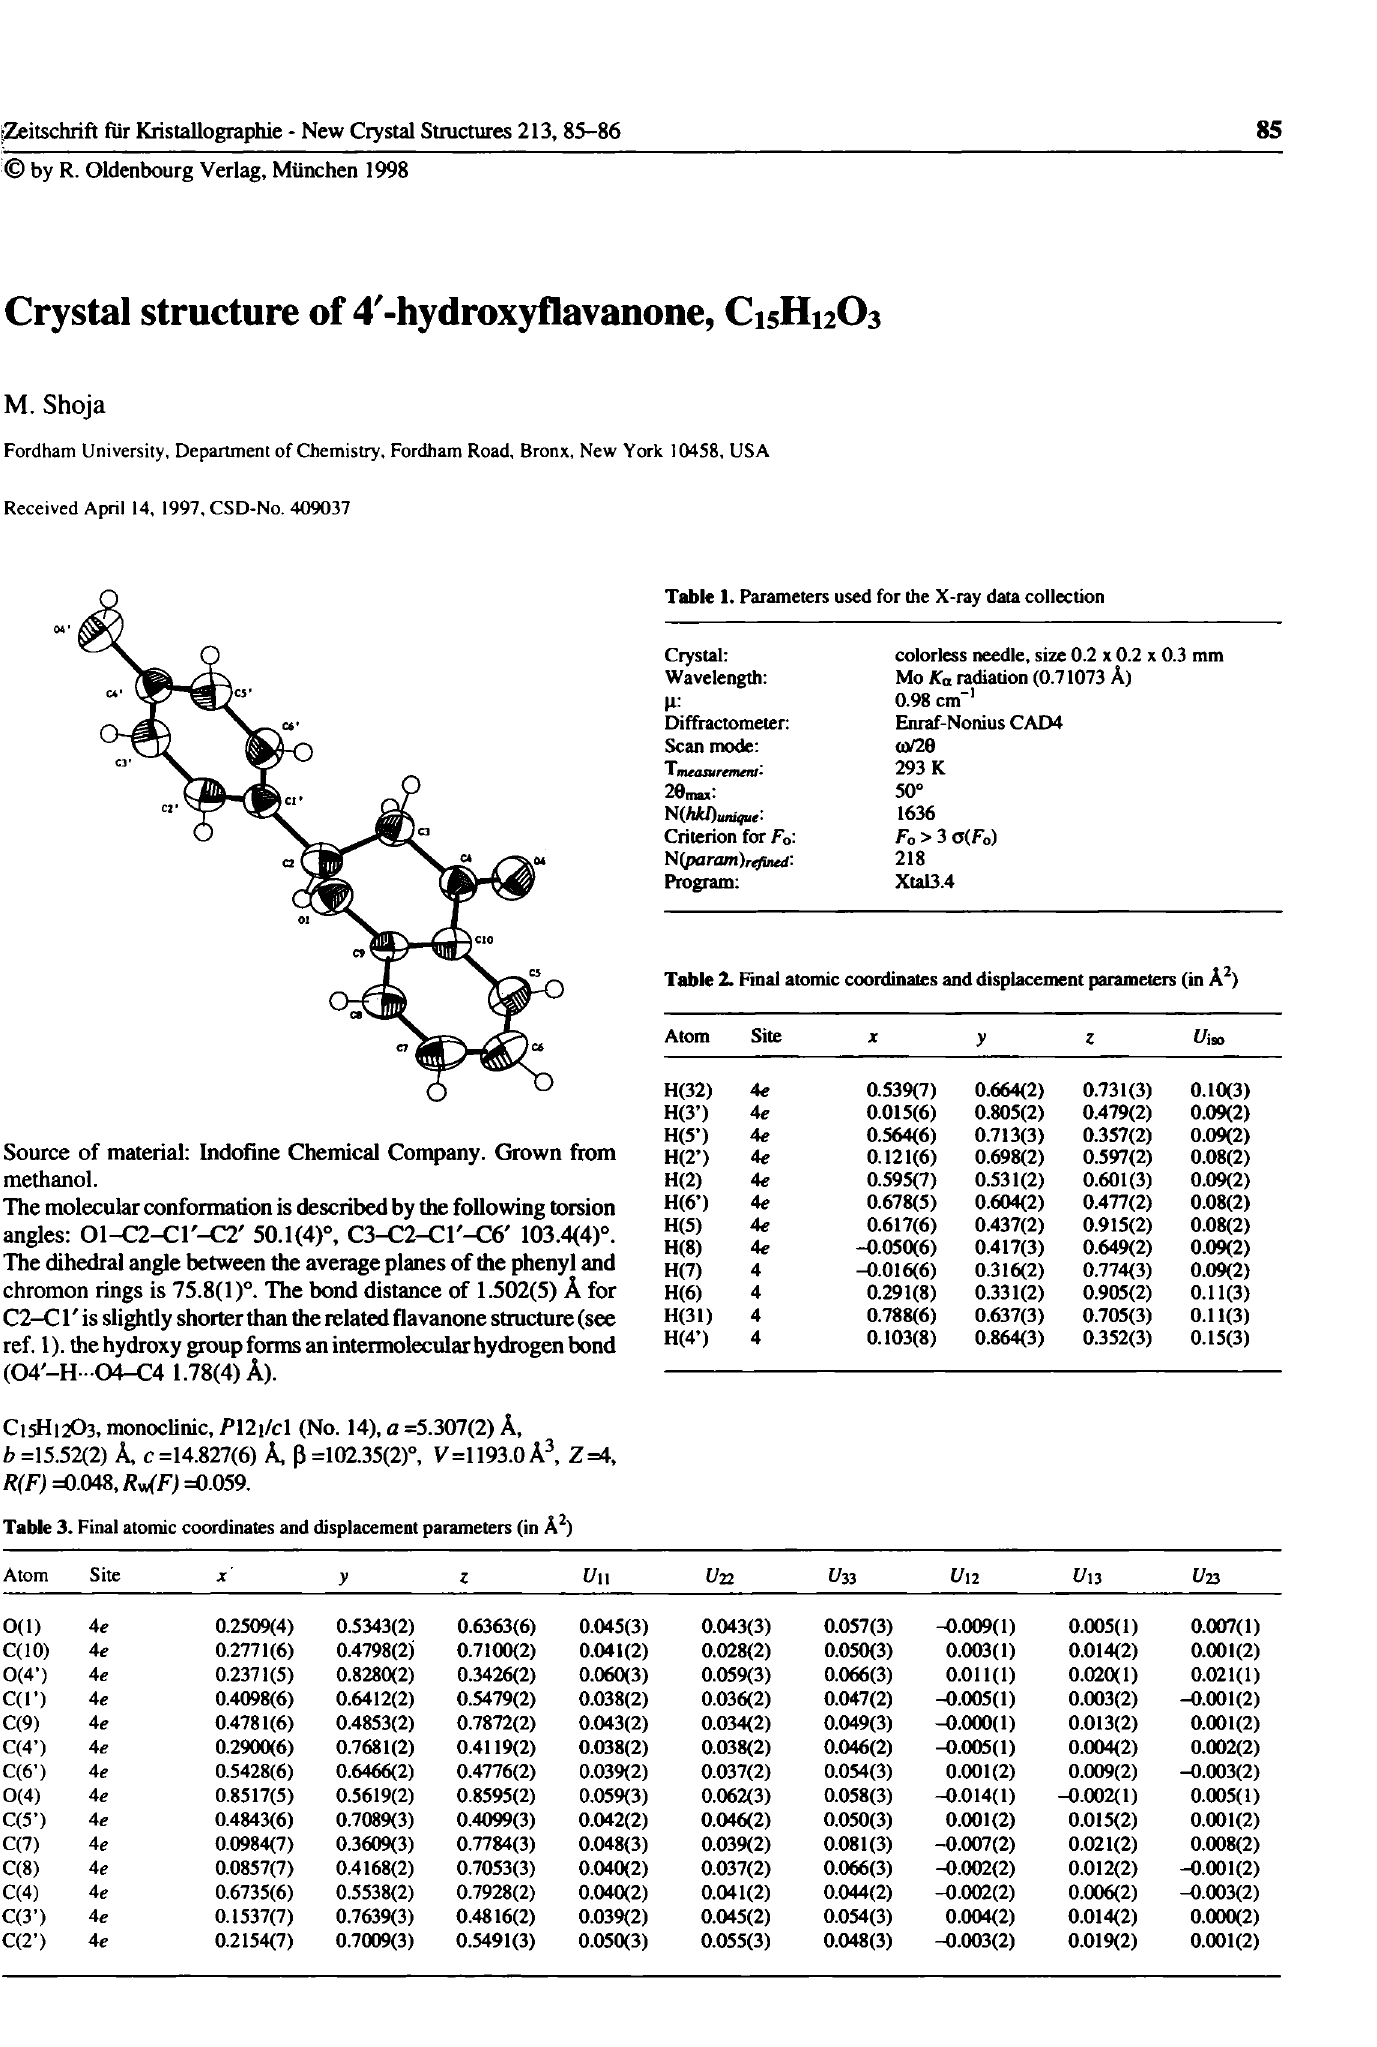
Source of material: Indofíne Chemical Company. Grown from methanol.